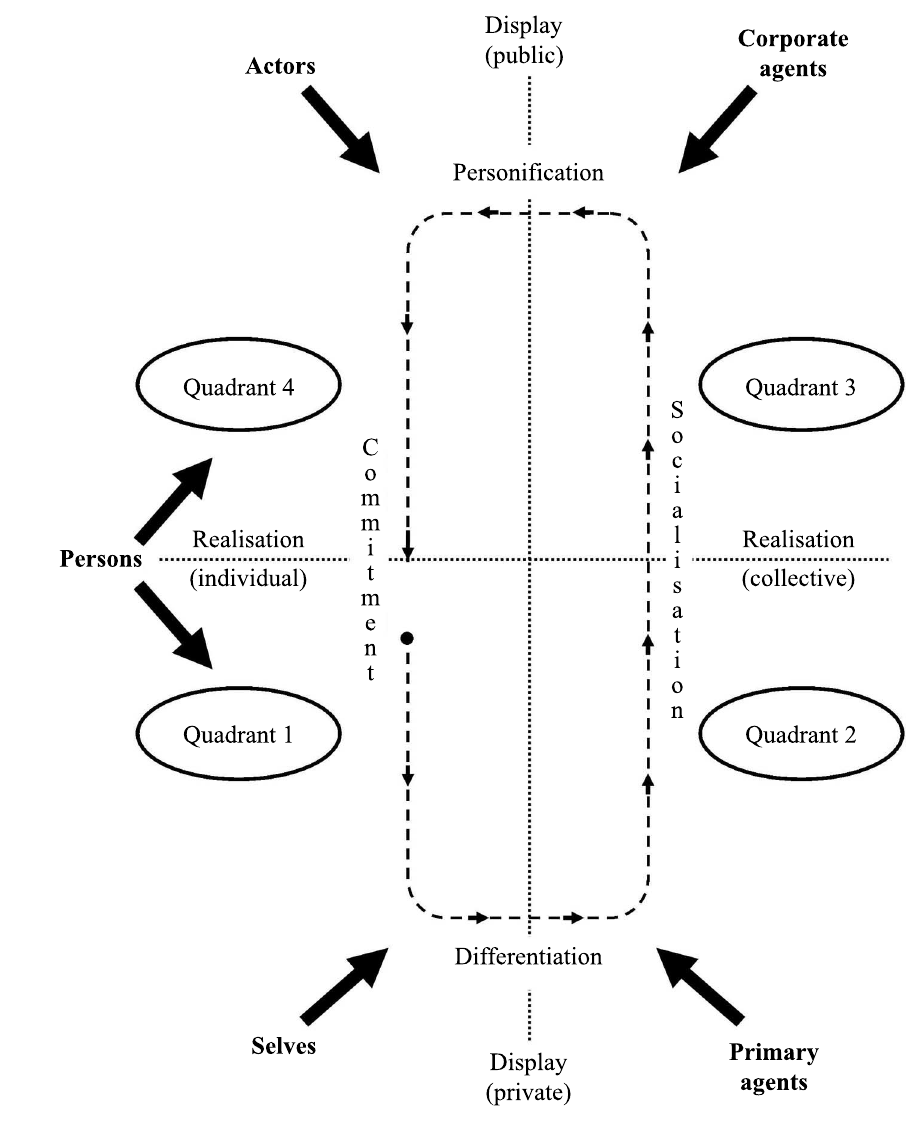
Figure 1. Realism’s account of the development of the stratified human being. Source: Archer (2000,